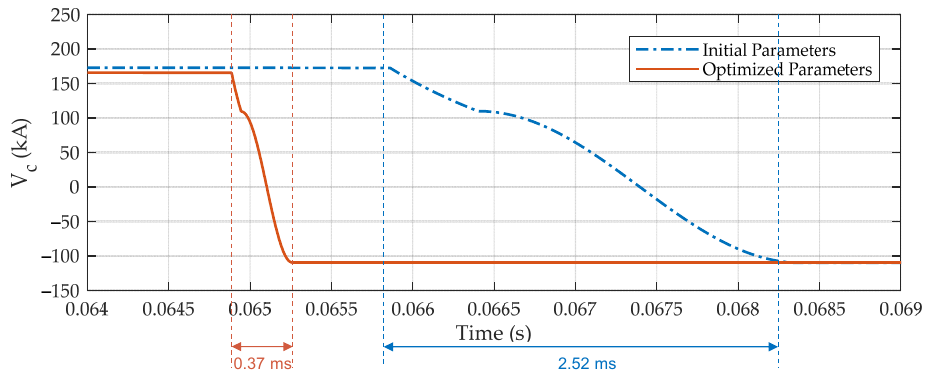
0.37 ms Figure 10. Voltage waveform of C in branch 2 of the Figure 10. Voltage waveform of C in branch 2 of the HCB Figure 10. Voltage waveform of C in branch 2 of the HCB Figure 10. Voltage waveform of C in branch 2 of the HCB